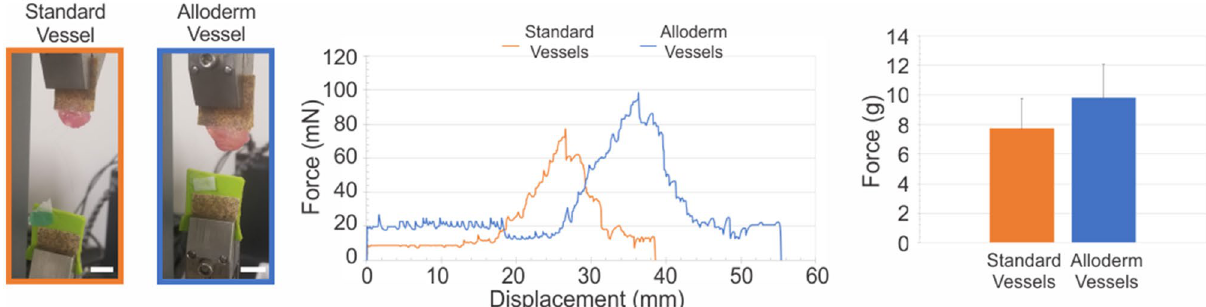
Figure 7. Average suture retention strength of engineered vessels increased with inclusion of Alloderm. Suture retention testing was performed on standard vessels (n = 5) and Alloderm vessels (n = 5). One end of the vessel was fixed to the tensile testing machine with sandpaper, with the suture glued to the other hook as shown. Both vessels experienced similar force output trends with respect to displacement. Alloderm vessels had a higher average maximum force compared to standard vessels. Scale bars = 1